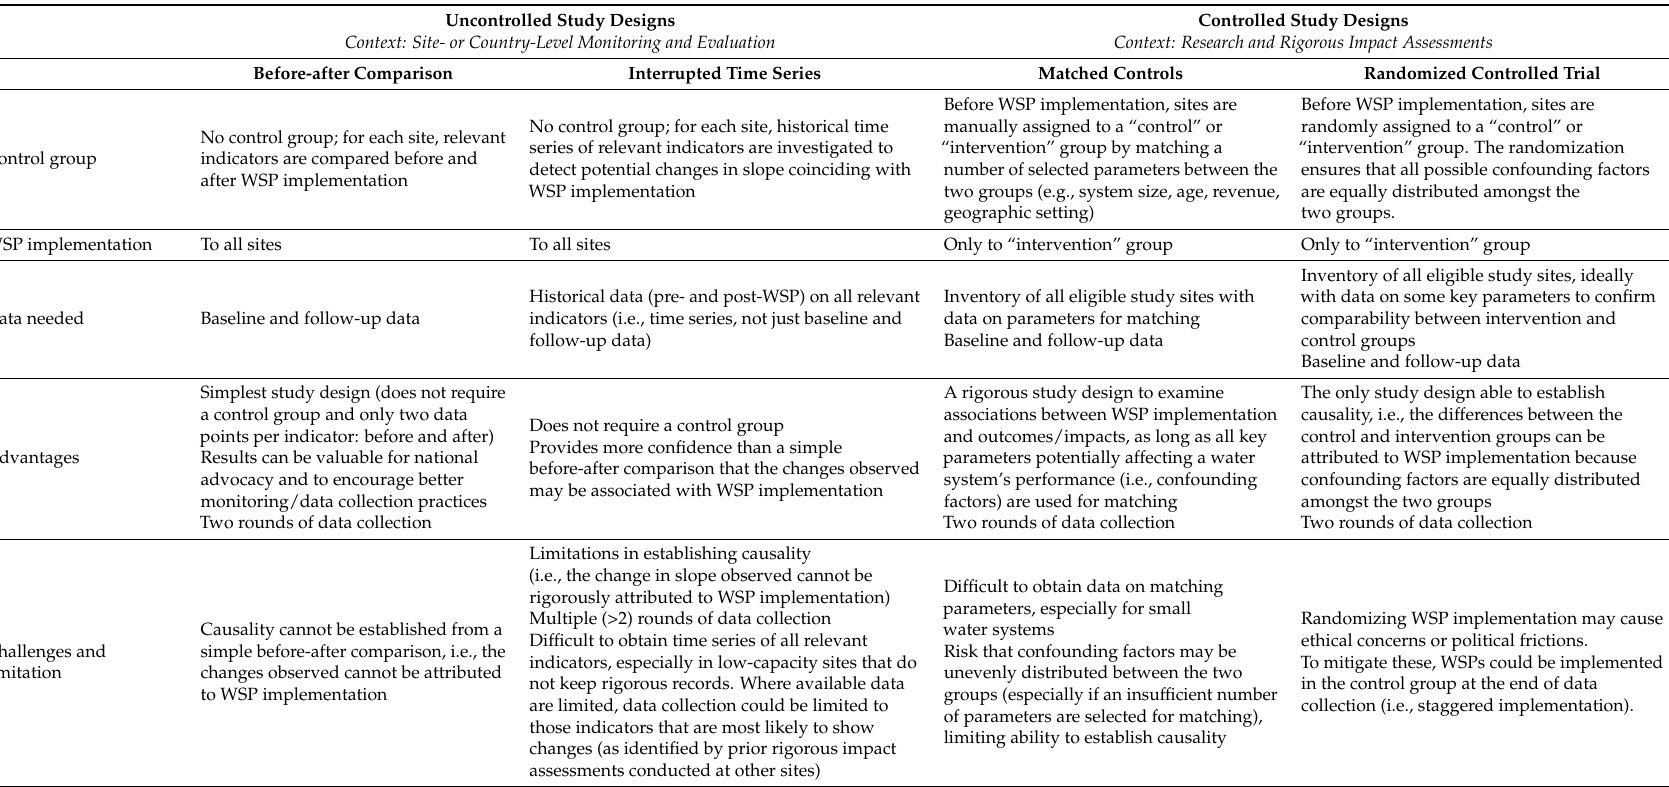
Table 5. Possible study designs for future WSP impact assessments, with advantages and